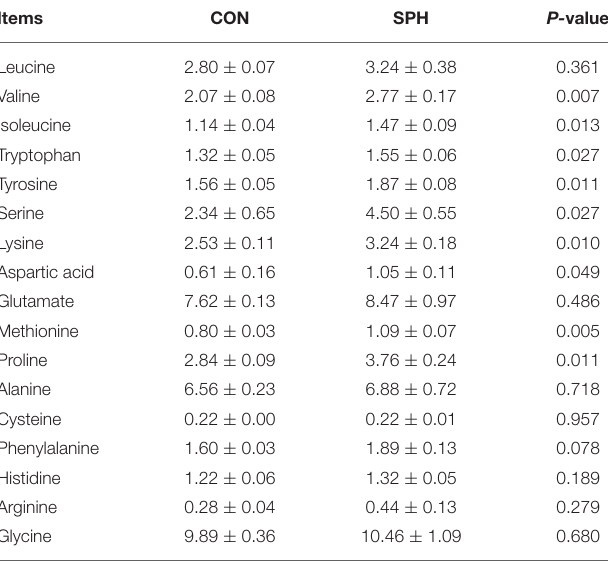
TABLE 2 | Hepatic amino acid levels in the CON and SPH groups. Items CON SPH P-